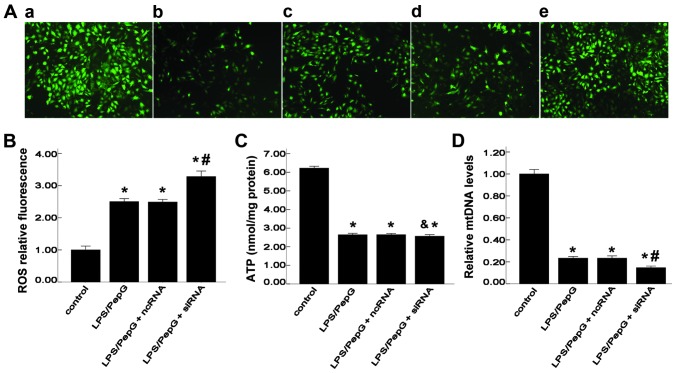
Effect of siRNA on intracellular reactive oxygen species (ROS) production, adenosine triphosphate (ATP) levels and mitochondrial DNA (mtDNA) copy numbers. The fluorescence intensity of DCF in H9C2 cells represented the production of intracellular ROS. (A) Changes in ROS production measured as the DCF fluorescence under a fluorescence microscope (magnification, x10); Panels a–e, ROS-positive control cells (Rosup), control, lipopolysaccharide (LPS)/peptidoglycan G (PepG), LPS/PepG + negative control siRNA (ncRNA) and LPS/PepG + siRNA group, respectively. (B) DCF fluorescence was read by a multifunctional microplate reader at an excitation wavelength of 488 nm and at an emission wavelength of 525 nm. (C) Cellular ATP expressed as nmol/mg protein was measured using a firefly luciferase-based ATP assay kit. RLU values were measured by a microplate reader. (D) Relative mtDNA copy numbers were detected by real-time PCR with normalization to 18s RNA. Values are expressed as the means ± SD. *P<0.05 vs. control group. #P<0.05, &P>0.05 vs. LPS/PepG group. n=3 per group.